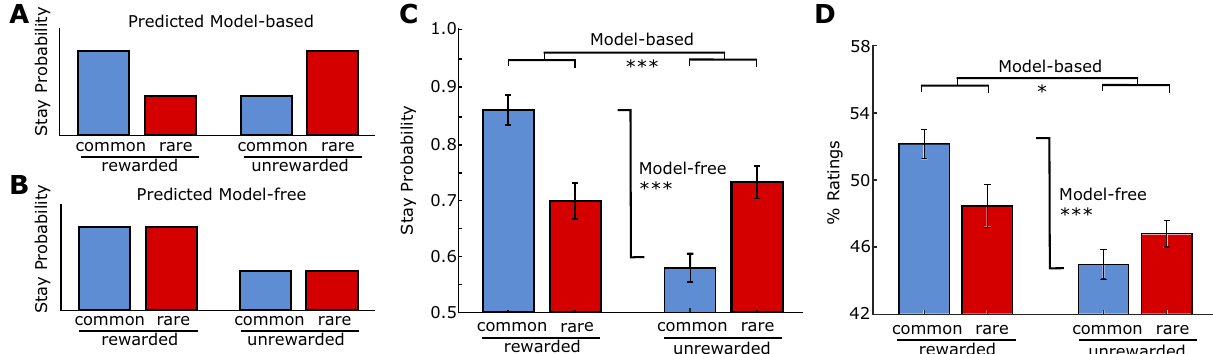
Figure 2. Subjects with explicit instructions showed mixed model-based/model-free choice and transfer. Idealised results of a pure ( A ) model-free and ( B ) model-based approach to the task in rewarded-unrewarded/ common-rare trials. ( C ) Contributions of model-free and model-based learning to stay probability, which measures how likely participants are to return to a particular stage 1 colour on the next trial. ( D ) Contributions of model-free and model-based learning to value ratings of the irrelevant stage 1 shapes. % Ratings indicate the average percentile of ratings. Here, we show the ratings of shapes split up by what happened on the most recent trial where that shape was chosen at stage 1. In particular, a shape was rated paradoxically higher if it led to a rare transition and no reward. Error bars represent within-subject standard error of the mean. *p < 0.05, **p < 0.01, ***p <